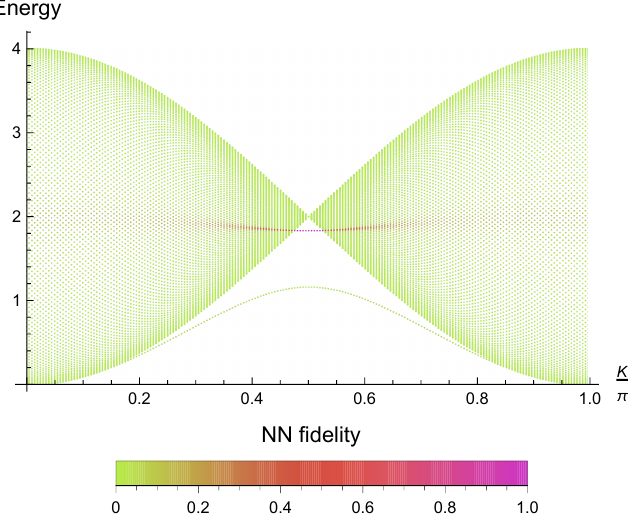
Figure 3: Two-magnon excitations and nearest neighbor fidelity for N = 200 and κ = −